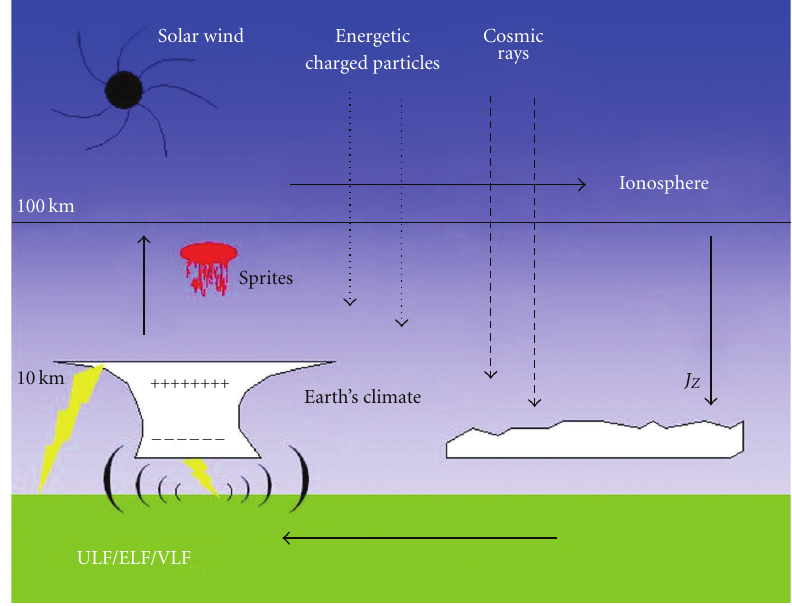
Figure 4: Essential features of the global atmospheric electric circuit [26, 27].